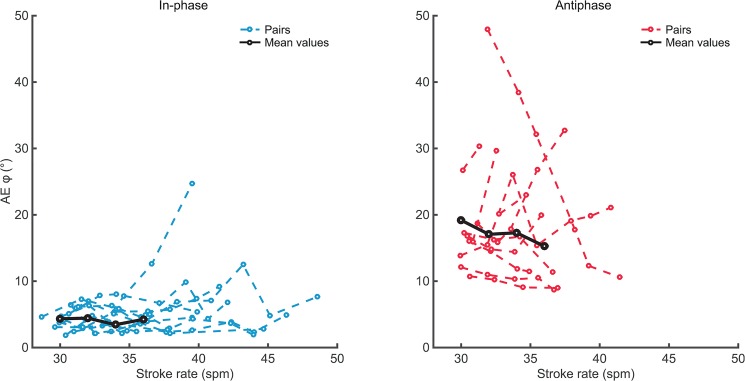
Accuracy of continuous relative phase.Absolute error of in-phase (left panel) and antiphase (right panel) crew coordination. Values depicted against performed stroke rates for all eleven dyads. Black lines indicate the means over the eight dyads as used in the RM ANOVA for stroke rates 30–36.